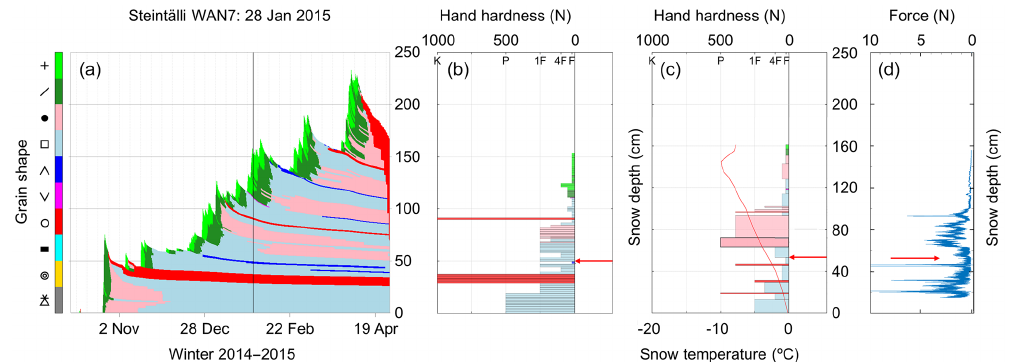
Figure 1. (a) SNOWPACK simulation for the location of the automatic weather station (AWS) WAN7 for winter 2014–2015 showing the evolution of grain shape, black vertical line indicates date of snow profile (28 January 2015), (b) simulated snow profile for 28 January 2015, (c) manually observed snow profile at the location of the AWS on 28 January 2015 and (d) corresponding SMP penetration force signal measured at the location of the manual profile. Red arrows point to the weak